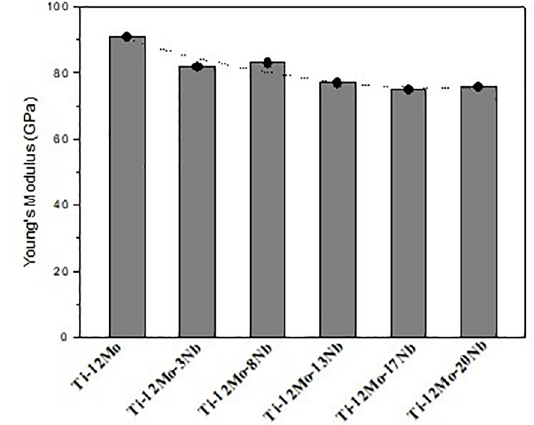
Figure 4. Variation of Young's modulus in according with increase the niobium content in the as–cast Ti-12Mo-xNb alloys. Nnamchi et al. 28 studied the effects of increase the niobium in binary alloys of the Ti-Mo-Nb-Zr system. Alloys contained 14wt.% and 40wt.% of niobium were arc melted and cooled inside the furnace. The results obtained indicated that produced alloys showed single β phase and Young’s modulus decrease: 14wt.% (95 GPa) and 40wt.% (90